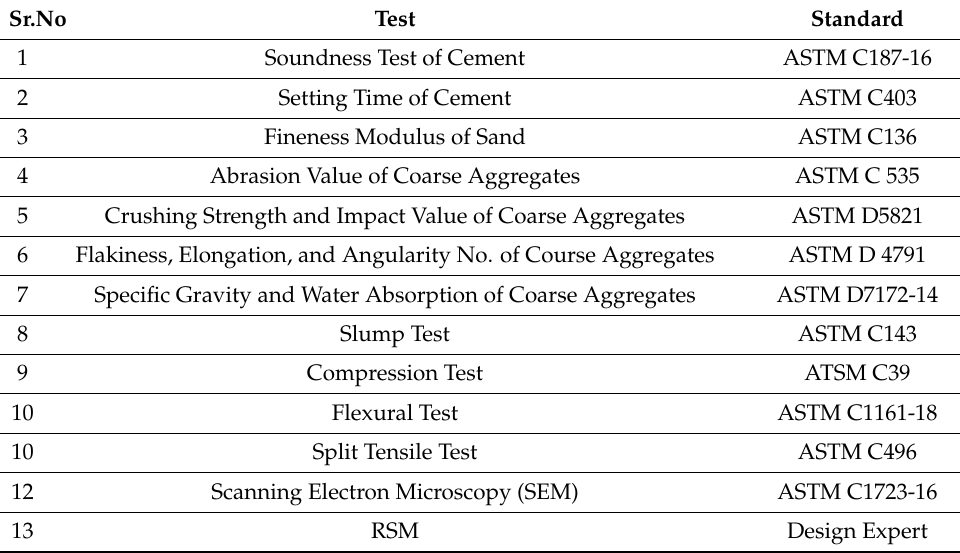
Table 5. Tests for measuring properties of